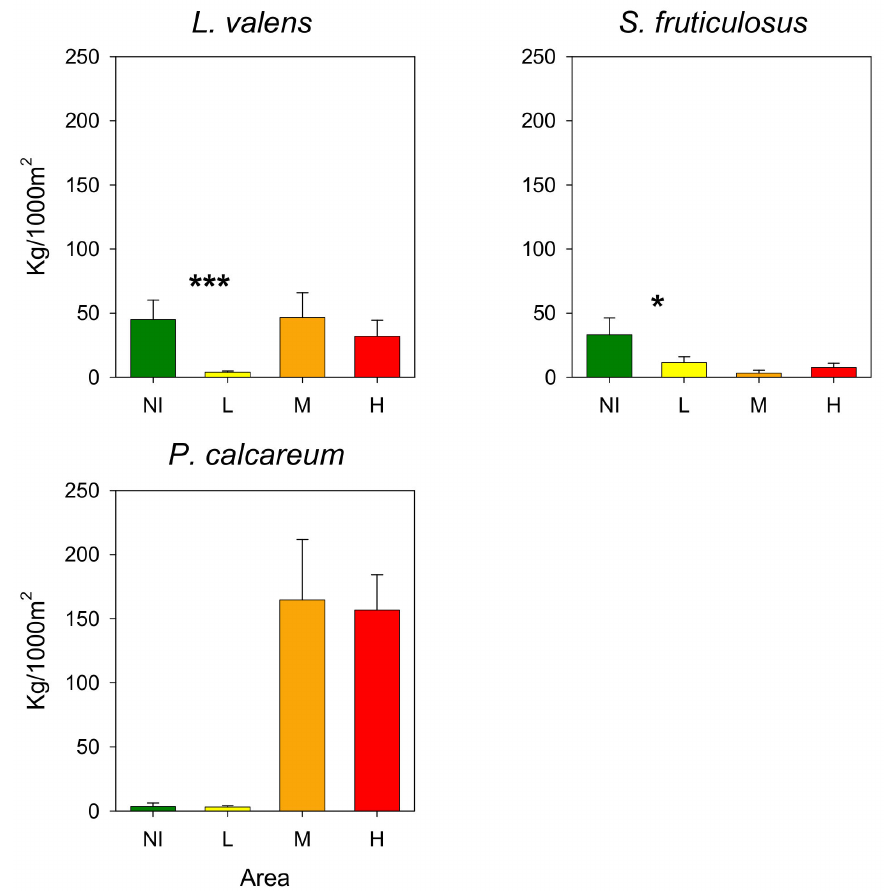
Figure 7. Mean values and standard errors of biomass (kg/1000 m 2 ) for the three species of rhodoliths, estimated from beam trawl samples in the four areas considered: Non-impacted (NI), Low effort history (L), Medium effort history (M), and High effort (H). p -values of the Student’s t -test to test for differences between areas are presented. * p < 0.05; ** p < 0.01; *** p < 0.001. Mean values of size and roundness for the rhodolith species selected are shown in Figure 8. Size and roundness of L. valens were higher in Non-impacted area (size: 44.5 ± 1 mm; roundness: 0.43 ± 0.01) than in Low effort history area (size: 40.8 ± 0.9 mm; roundness: 0.37 ± 0.01). Size and roundness of S. fruticulosus were also higher in Non- impacted area (size: 35.8 ± 0.7 mm; roundness: 0.73 ± 0.01) than in Low effort history area (size: 32.4 ± 0.7 mm; roundness: 0.67 ± 0.01). P. calcareum did not show significant differences in size in any area, but it showed higher values of roundness in Non-impacted area (0.30 ± 0.02) compared to Low effort history area (0.25 ±